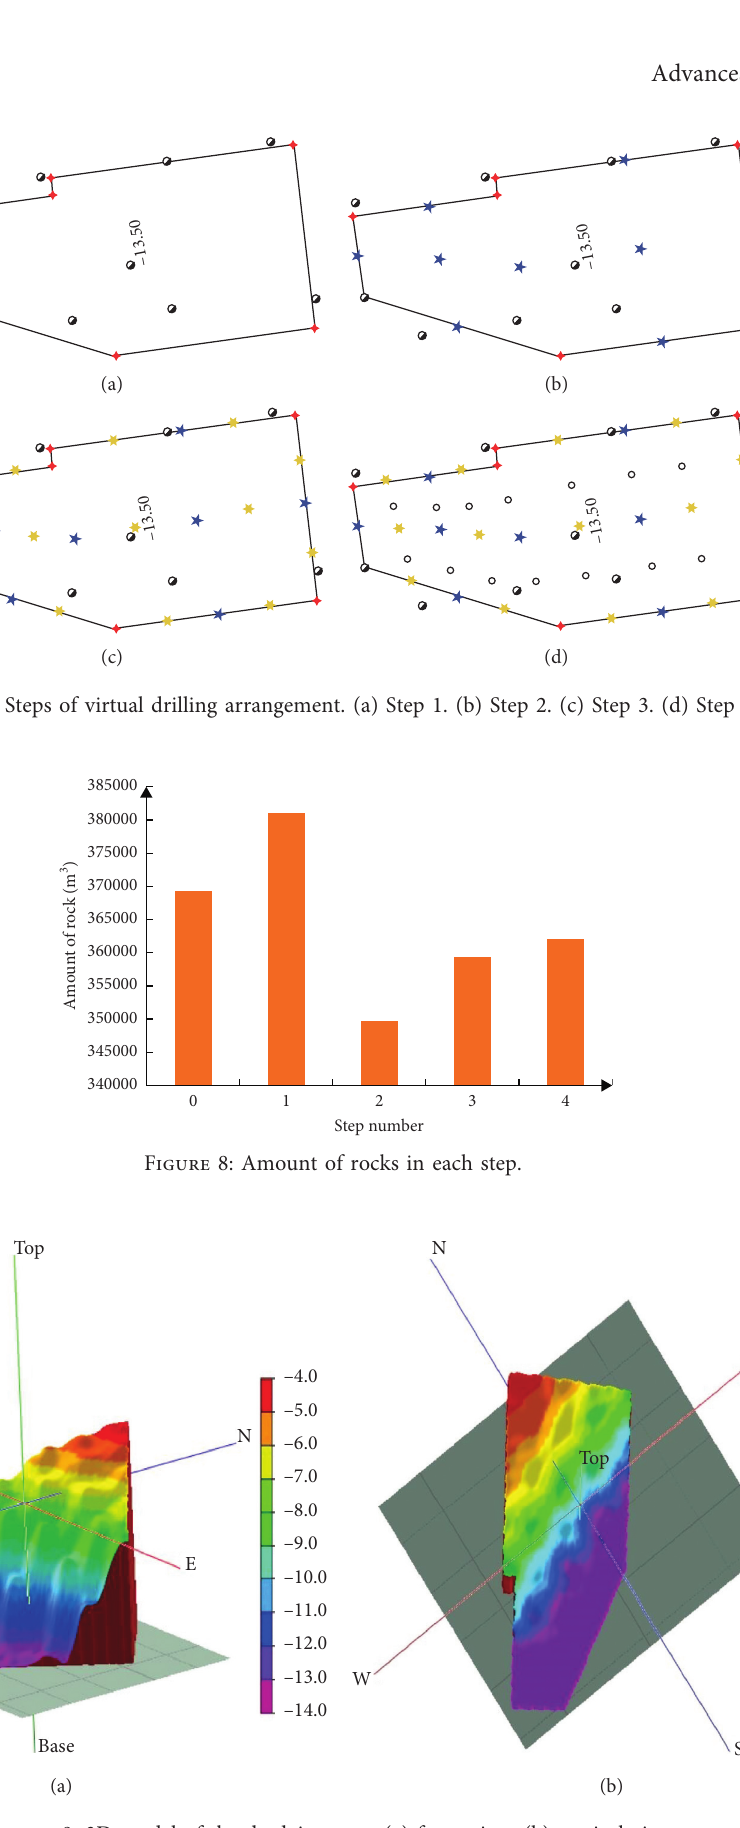
Figure 9: 3D model of the dredging area: (a) front view; (b) vertical